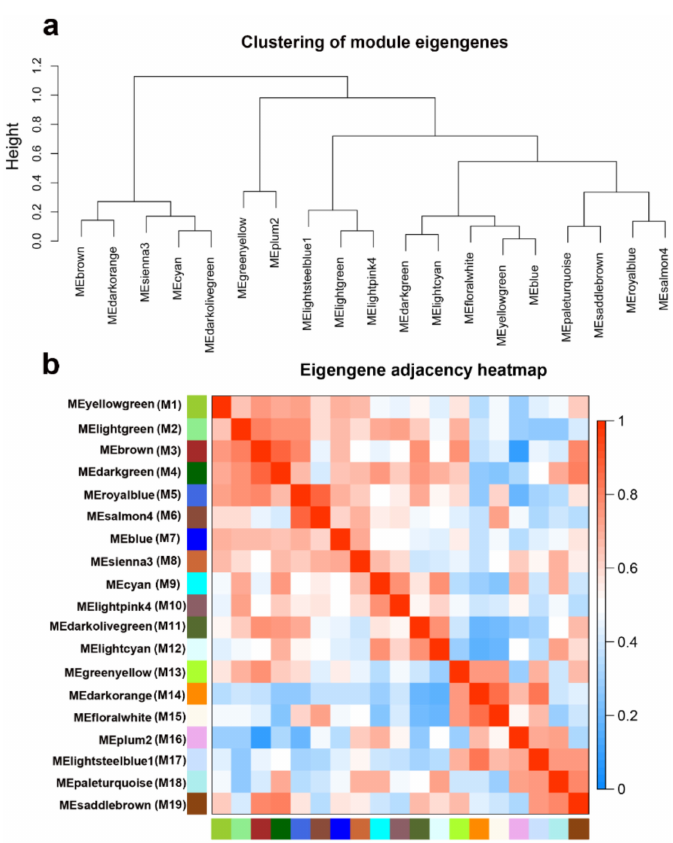
Figure 9. Analysis of connectivity of eigengenes in di ff erent module. ( a ) Cluster analysis of eigengenes. ( b ) The heatmap of connectivity of